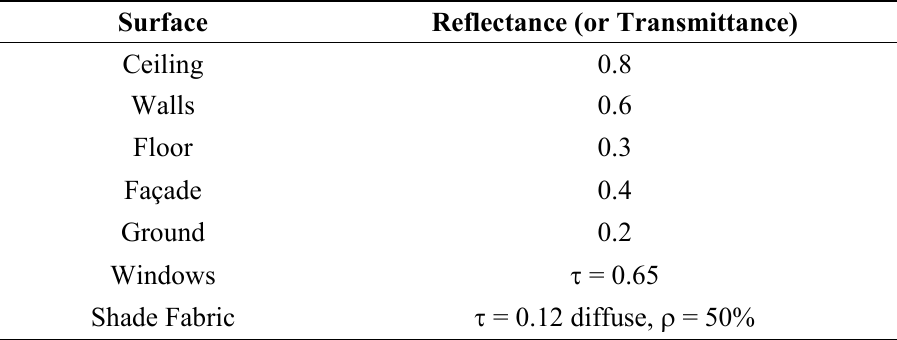
Table 1. Material properties for the daylighted classroom